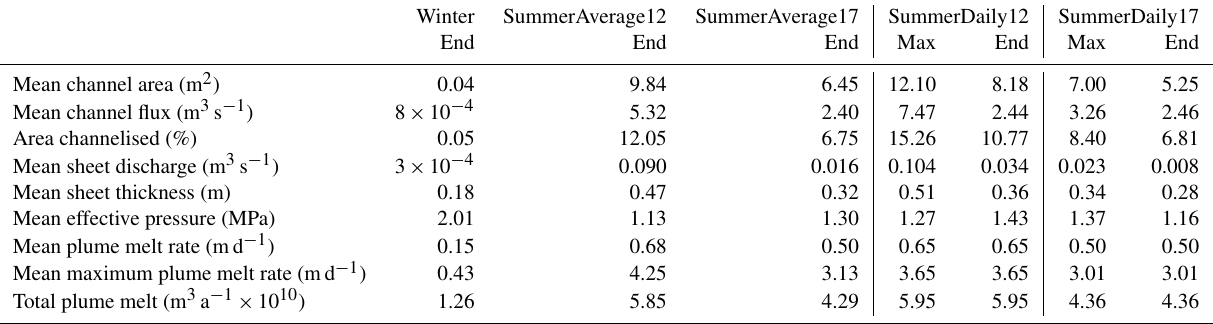
Table 3. Summary of key simulation results. The channel, sheet and pressure statistics are taken from the final time step across the entire model domain (columns marked “End”) or the time step where maximum mean channel area in the simulation was reached (columns marked “Max” – this occurred on time step 60 for SummerDaily12 and time step 74 for SummerDaily17) – for the average-forced runs, the end time step is also the max time step, so only figures for the end time step are shown; the plume statistics are taken from the calving front across all time steps. “Area Channelised” refers to the percentage of the possible channel segments occupied by channels > 1m 2 in